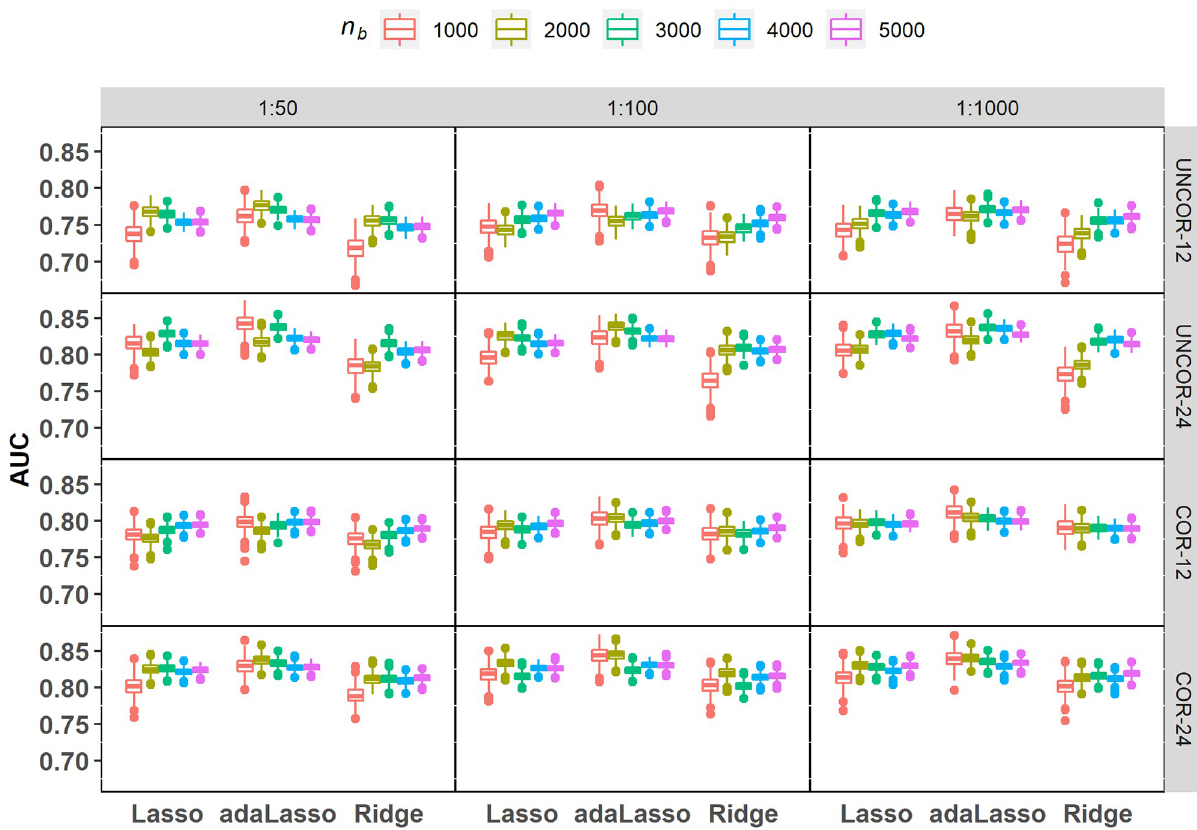
Fig 2. Predictive performance for various regularized logistic regression models fitted to simulated balanced datasets with imbalance ratios 1:50, 1:100 and 1:1000. AUC values reported here correspond to λ